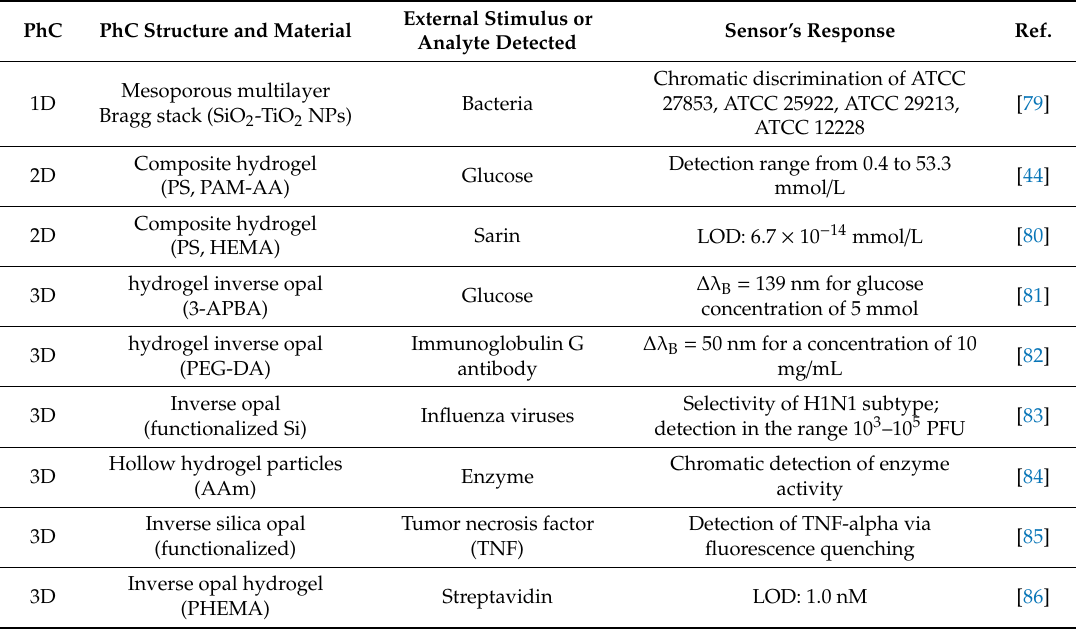
Table 4. Summary of photonic crystal biological sensors. The first column (left) indicates the dimensionality of the PhC, whereas the second column indicates the type of structure and its constituting materials. In the sensor’s response columns, ∆ λ B is the value of the shift of the Bragg peak’s wavelength induced by the external stimulus or analyte (third column). When available, the value of the limit of detection (LOD) is